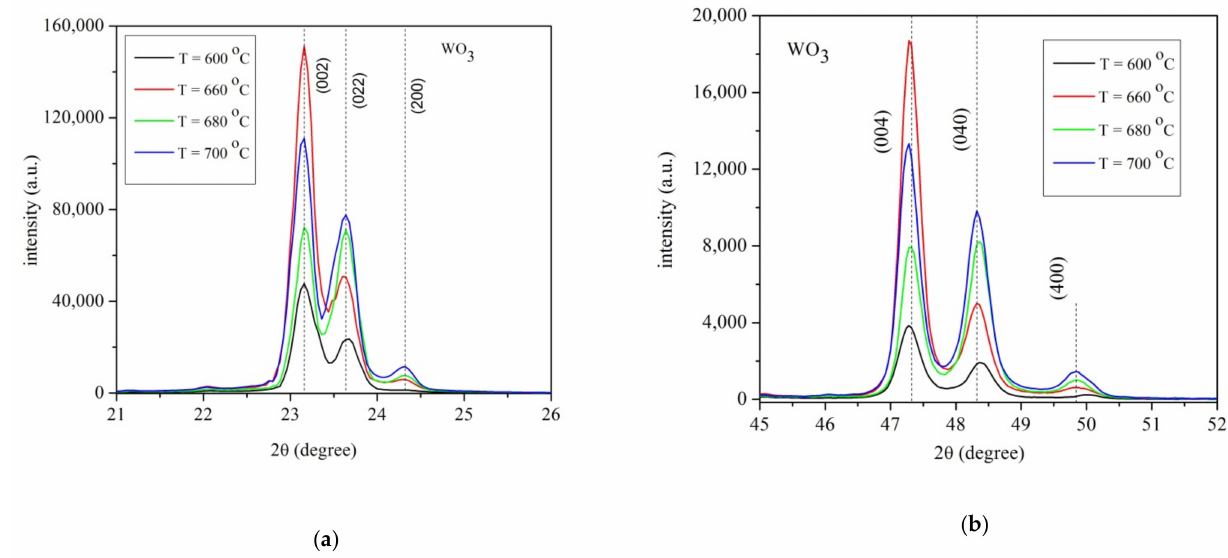
Figure 1. X-ray patterns for WO 3 layers grown on sapphire substrate at temperatures T = 600 ◦ C, T = 660 ◦ C, T = 680 ◦ C, T = 700 ◦ C and deposition time 4 h.( a ) range 2 θ = 21–26 ◦ ; ( b ) range 2 θ = 45–52 ◦